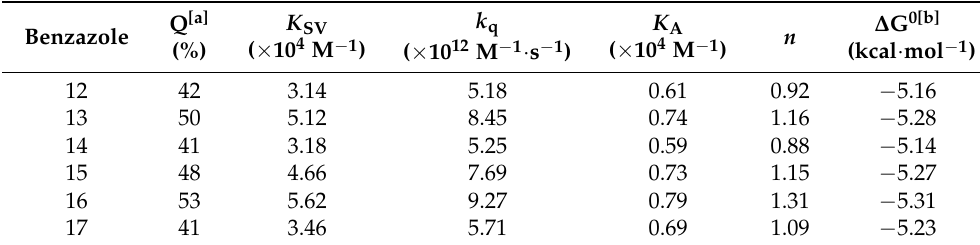
Figure 4. The linear plot from the Stern–Volmer relationship of ESIPT fluorescent lipophilic (a) benzoxazoles 12 – 14 and (b) benzothiazoles 15 – 17 . Table 2. BSA-binding parameters for benzazoles 12 – 17 , where Q is the quenching percentage, K SV is the Stern–Volmer quenching constant, k q is the bimolecular quenching rate constant, K a is the binding constant, n is the number of binding sites, and Δ G 0 is the Gibbs free energy for the BSA–benzazole interaction.